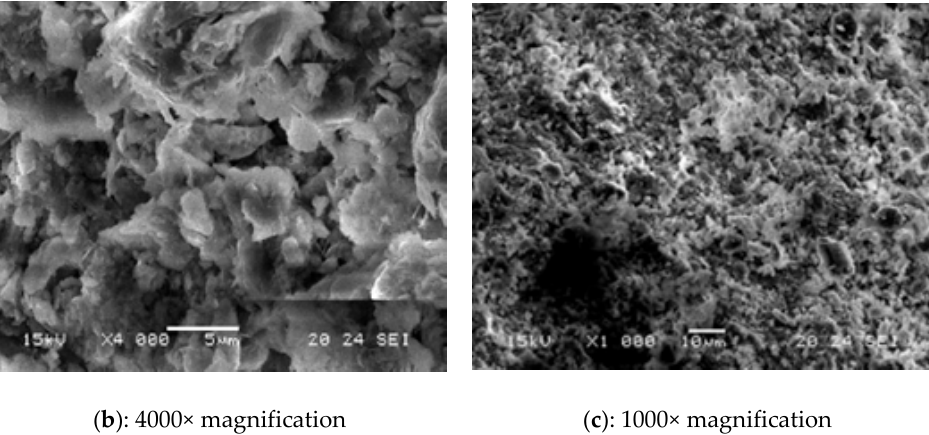
Figure 3. ( a ) Mass percentage of minerals contained in the hydroxide sludge; ( b , c ) Micrograph analysis of the hydroxide sludge.